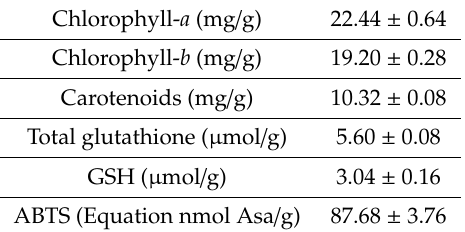
Table 1. Content of pigments and total and reduced glutathione and antioxidant capacity of Chlorella